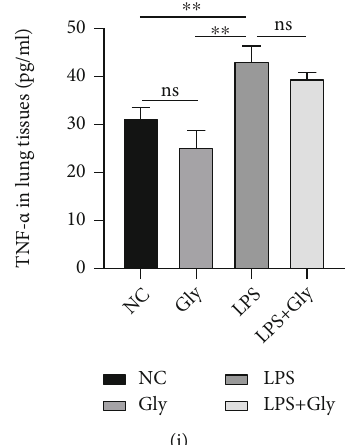
Figure 2: The e ff ect of glibenclamide on the LPS-stimulated in fl ammatory response in lungs. (a) The total cell number counts in BALF ( n = 3 ). (b, c) The percentage of neutrophils and macrophages is presented ( n = 3 ). (d – i) The content of IL-1 β , IL-18, and TNF- α in (d – f ) BALF ( n = 3 ) and (g – i) lung tissues ( n = 3 ) was measured by ELISA. Data are representative of three independent experiments (mean and SD). ns: not signi fi cant. ∗ P < 0 : 05 , ∗∗ P < 0 : 01 , ∗∗∗ P < 0 : 001 , and ∗∗∗∗ P < 0 : 0001 (unpaired Student ’ s t